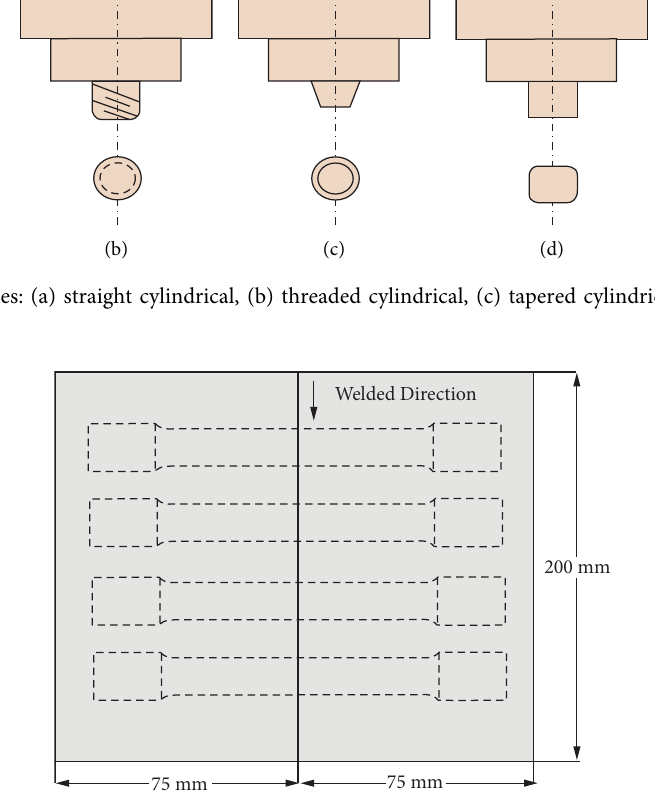
Figure 3: Specimens for tensile testing in the FSW joints. Table 1: Dissimilar alloys’ chemical composition.